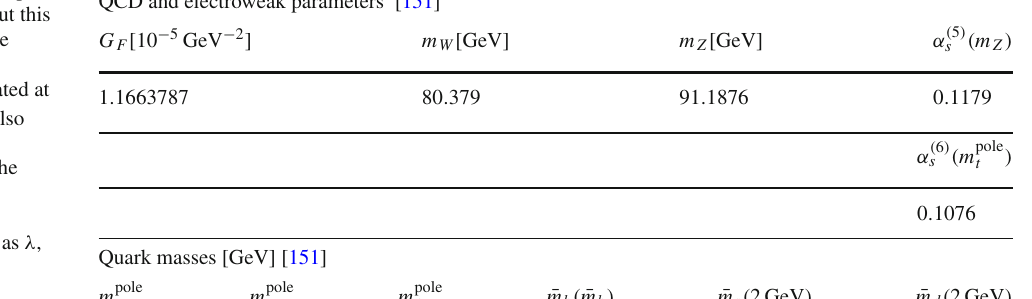
QCD and electroweak parameters